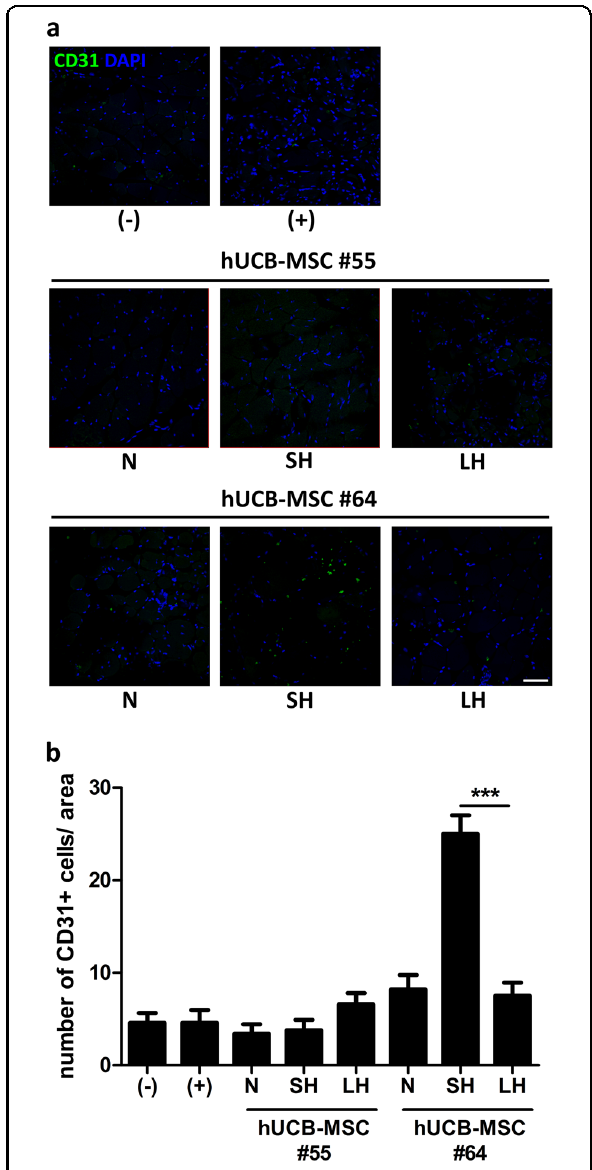
Fig. 4 Promoted hindlimb angiogenesis of the ischemic lesions show different effects among culture conditions and donors. a Representative image of CD31-positive blood vessels (green) from the adductor muscle section among groups. Scale bar = 50 μ m. b Quanti fi cation of CD31-positive capillaries among groups. *** P < 0.001. Results are shown as the mean ±